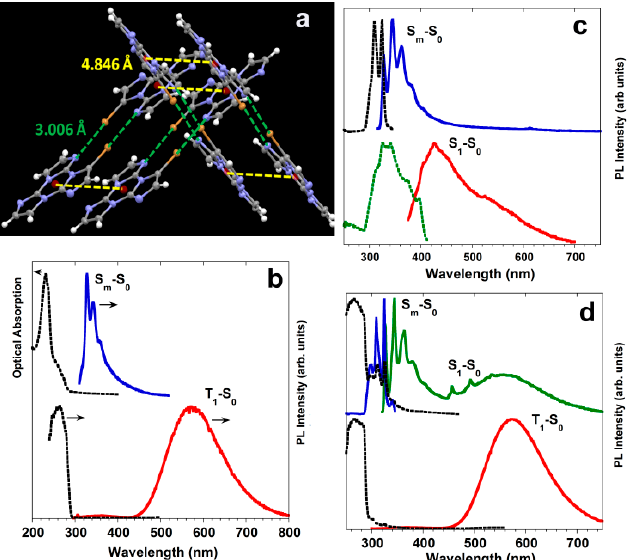
Figure 8. Compound 34 . ( a ) Crystal packing: π - π stacking interactions and Br ... N XB shown as yellow and green dotted lines, respectively. ( b ) In DCM: top: absorption and emission ( λ ex = 280 nm) at RT; bottom: excitation (black dotted line, λ em = 580 nm) and emission (red line, λ ex = 280 nm) at 77 K. ( c ) Powders at RT: top: excitation (black dotted line, λ em = 363 nm) and emission (blue line, λ ex = 300 nm); bottom: excitation (green dashed line, λ em = 429 nm) and emission (red line, λ ex = 360 nm). ( d ) Powders at 77 K: top: emission (green line, λ ex = 300 nm) and excitation (blue line, λ em = 363 nm; black dashed line, λ em = 492 nm); bottom: excitation (black dashed line, λ em = 580 nm) and emission (red line, λ ex = 280 nm). Reprinted with permission from [48]. 3-(Pyridin-2-yl)triimidazo[1,2- a :1 (cid:48) ,2 (cid:48) - c :1”,2”- e ][1,3,5]triazine, 37 (Scheme 10), is the only member of the TT family showing anti-Kasha behavior from an excited